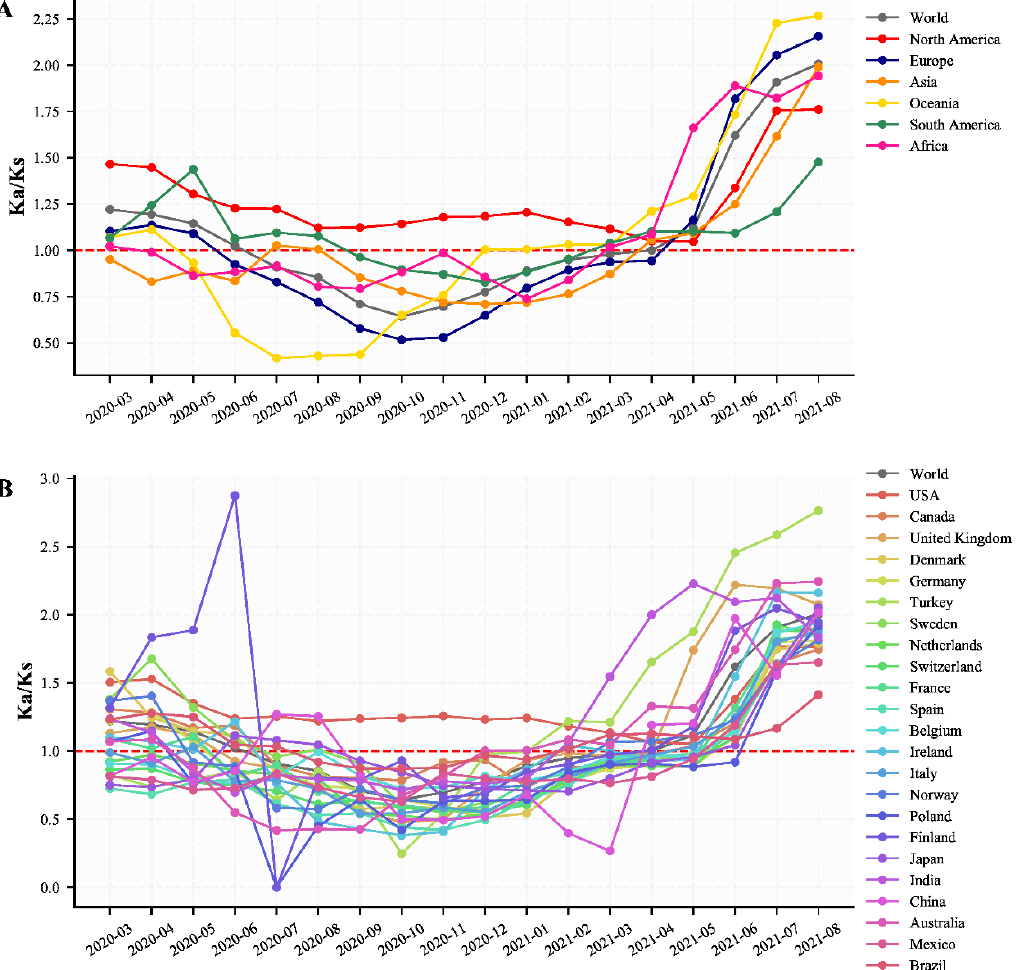
Figure 2. The changes of the estimated ratio of the rates of non-synonymous to synonymous changes (Ka/Ks) of SARS-CoV-2. The Ka/Ks of SARS-CoV-2 between December 2019 and March 2020 was calculated as a whole as there are too few genome sequences in the early stage. ( A ) The changes of Ka/Ks in different continents. ( B ) The changes of Ka/Ks in different countries or regions with more than 10,000 genome sequences and